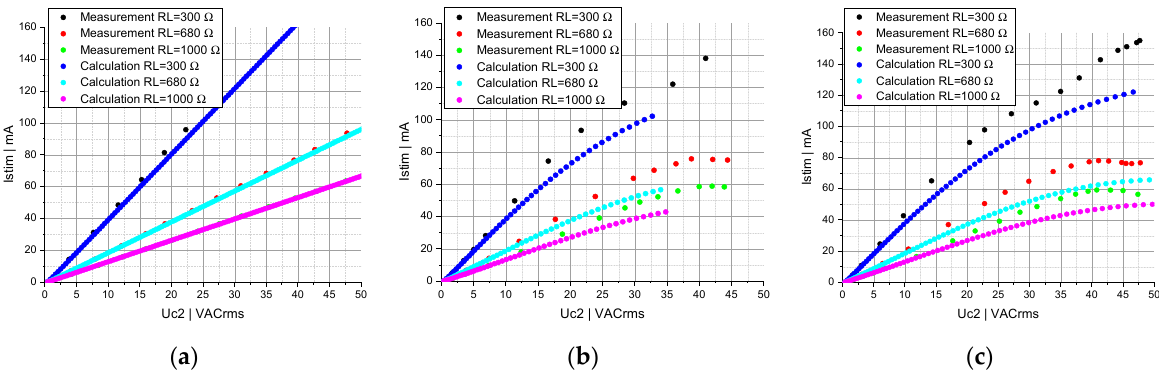
Figure 8. Stimulation current Istim as a function of the induced voltage Uc2 for a circuit topology of: ( a ) four series-connected linear capacitors; ( b ) two series-connected linear and two series-connected nonlinear capacitors; ( c ) four series-connected nonlinear capacitors. The measurements (black, red, green) and calculations (blue, cyan, magenta) were performed for R L = 300 Ω , 680 Ω and 1000 Ω , respectively.